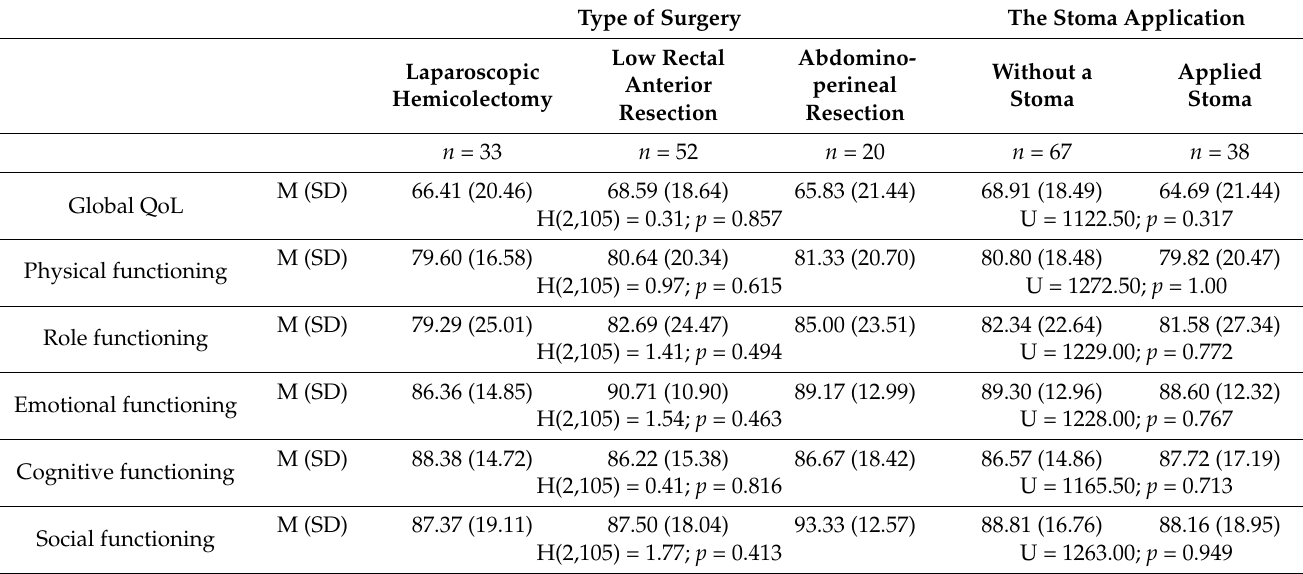
Table 3. Quality of life due to the type of surgery and the use of a stoma in T2 ( n = 105). Type of Surgery The Stoma Application